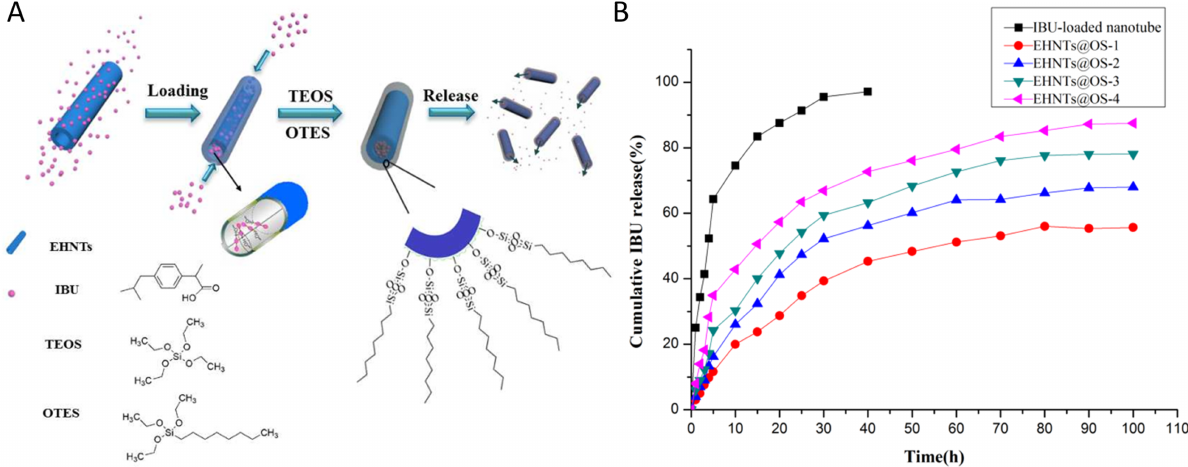
Figure 9: Schematic representation of IBU loading, modification, and drug-release process (A). Release profiles of IBU from the EHNTs@OS with different compositions (conducted) by Zhong et al. [81]